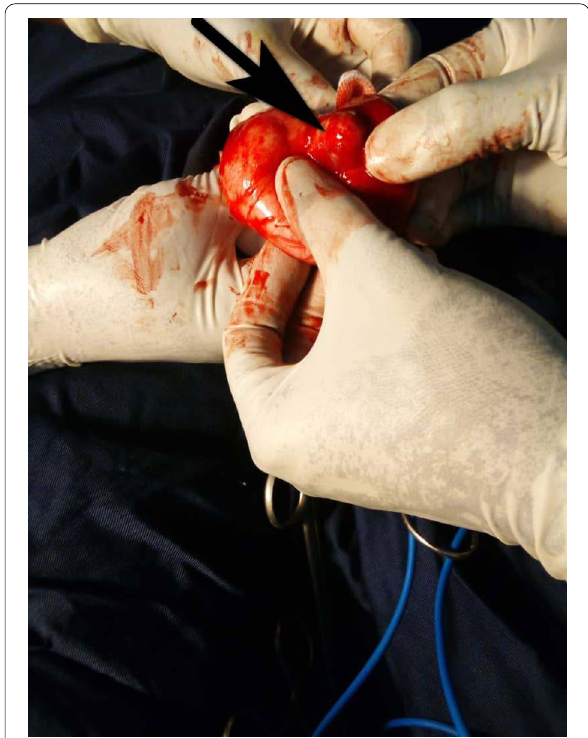
Fig. 1 The operative view of the tumor showing a well-defined nodule in the head of the epididymis (black